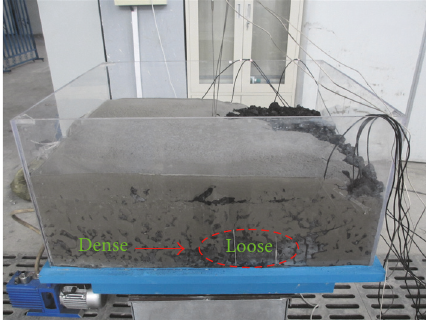
Figure 7: Penetration and diffusion form of the foam fluid in the 𝑋 - 𝑍 section.